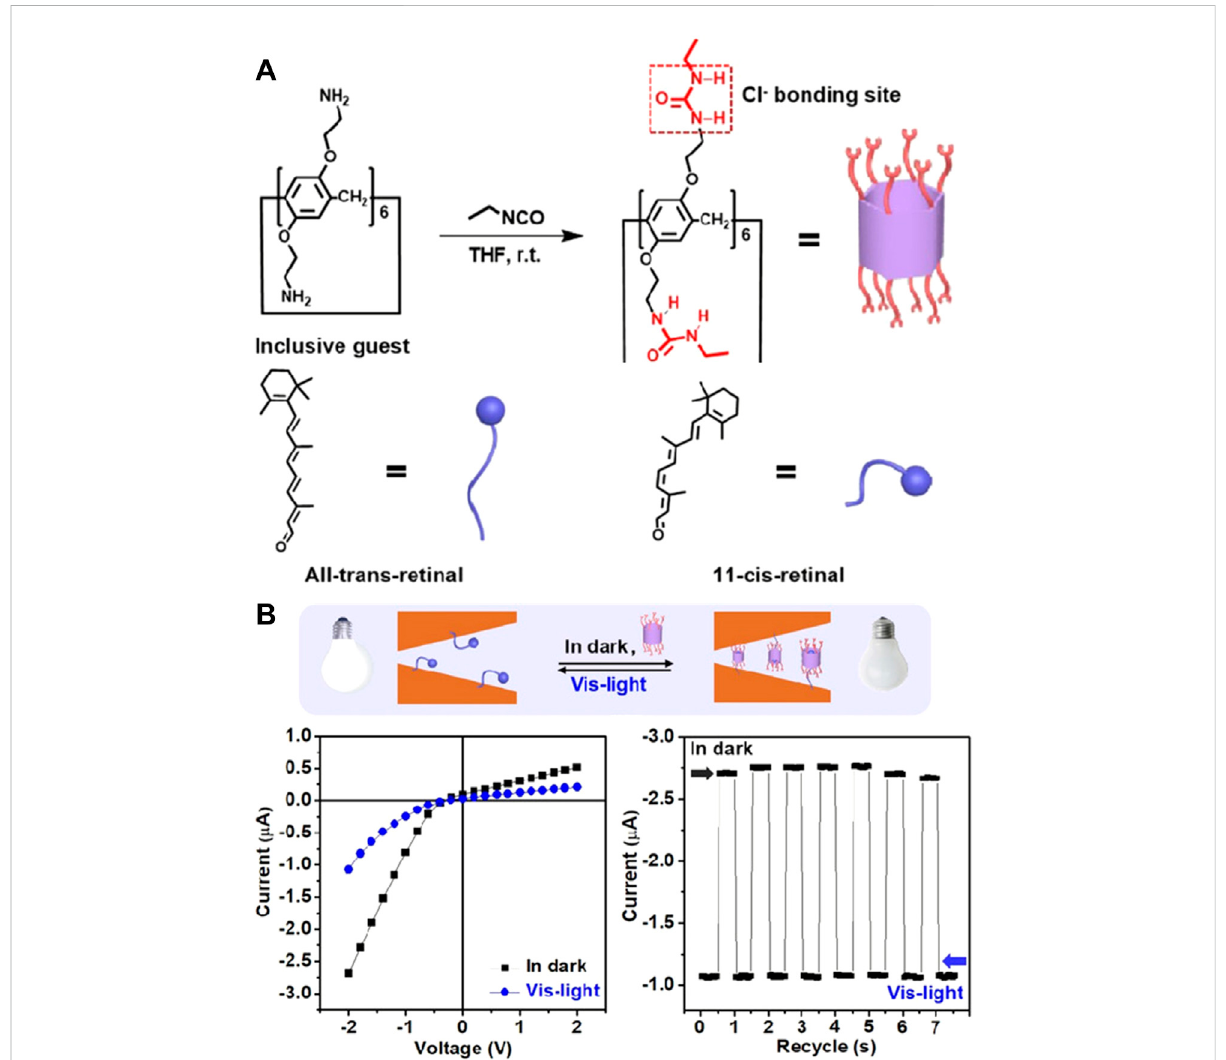
FIGURE 7 (A) Synthesis process of the ethyl urea-derivative pillar[6]arene and the cis-trans structure change of the retinal molecule; (B) changes in the ionic current in the nanochannel before and after irradiation by visible light. This process was recycled seven times by the test of I-T current